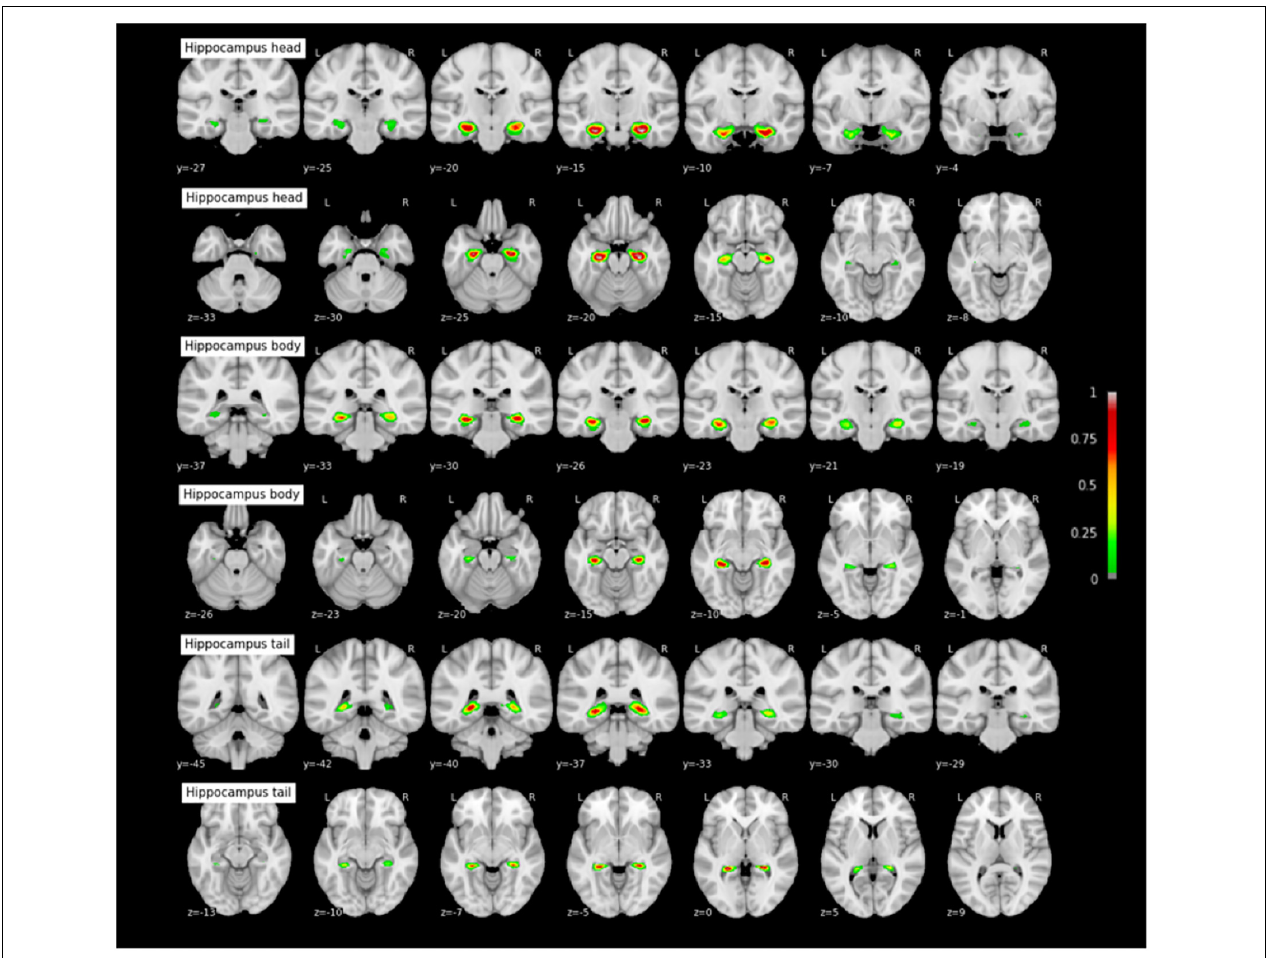
FIGURE 11 | Probabilistic maps of the hippocampal subparts. The maps are normalized into the MNI stereotaxic space. Coordinates are indicated on each slice.